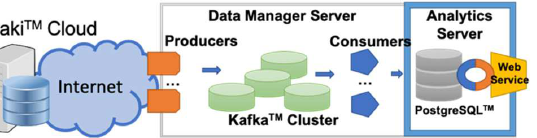
Figure 1. The connection architecture of the Wi-Fi network and computing services for data processing.